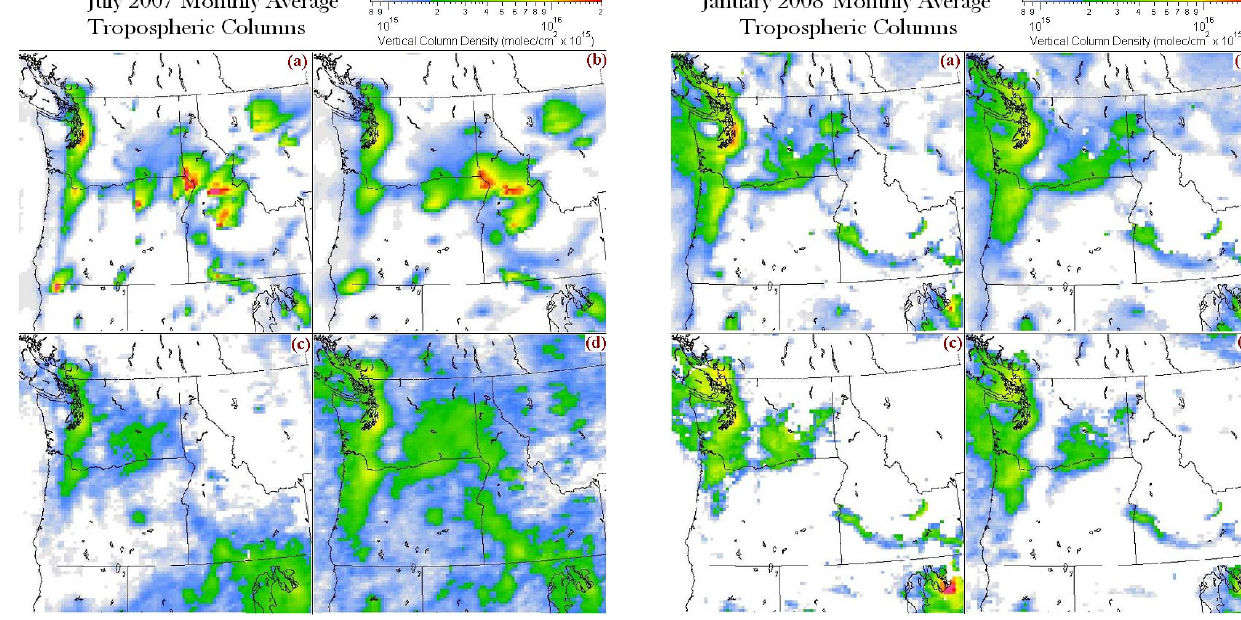
Fig. 4. Average tropospheric NO 2 columns are shown for the month of July, 2007: AIRPACT (a) at upper left, spatially averaged AIR- PACT (b) at upper right, KNMI OMI (c) at lower left, and NASA OMI (d) at lower right.